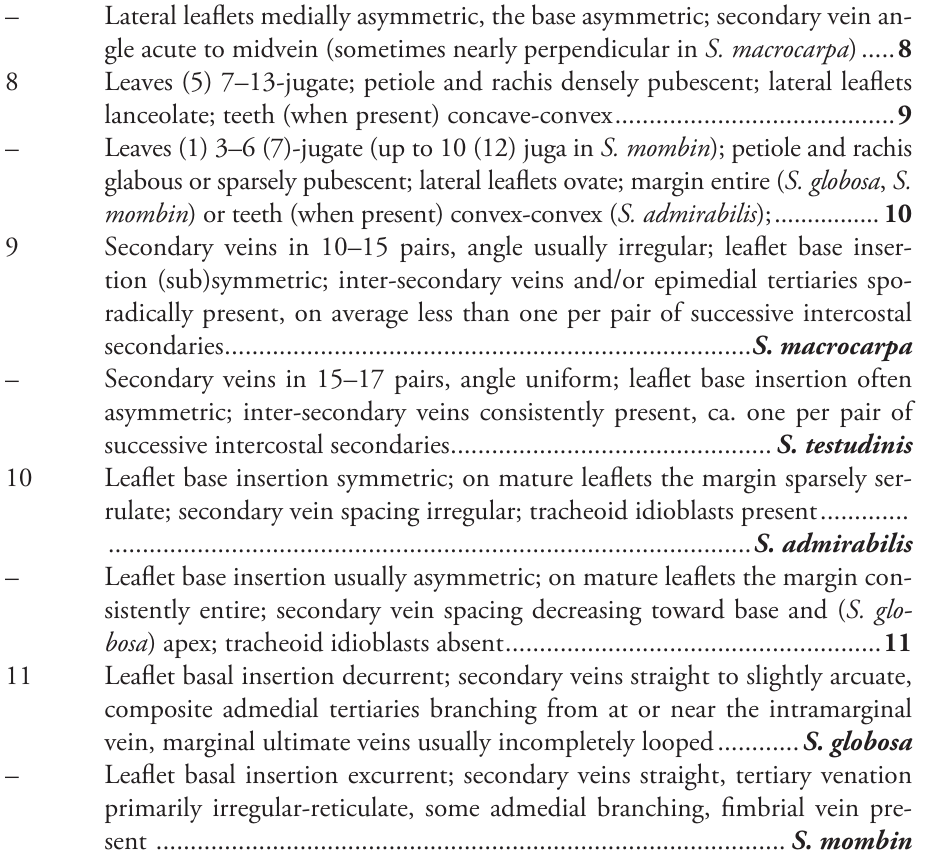
venulosa (Mart. ex Engl.) Engl. because the leaves mostly 3–5-jugate, some parallel in- tersecondary veins present, and composite admedial tertiary veins, and flower annular disk short and thick; S. admirabilis differs by the leaflets chartaceous to membranaceous and dull (vs. coriaceous and glossy), the margin slightly revolute and serrulate (vs. revo- lute only at base and entire or less often broadly crenulate), 7–13 (vs. 10–20) secondary vein pairs, stamens 1.5–2 and 1.4–1.95 (vs. 1.2–1.3 and 0.9–1.1) mm long, and the fruit 1.8–3.2 (vs. 3.6–6) cm long, depressed-globose (vs. oblong or less often obovoid). Type. BRAZIL. Rio de Janeiro: Ponta da Jararaca, 13 Apr 2000, C. Farney & J. C. Gomes 4046 (holotype: RB!; isotype: